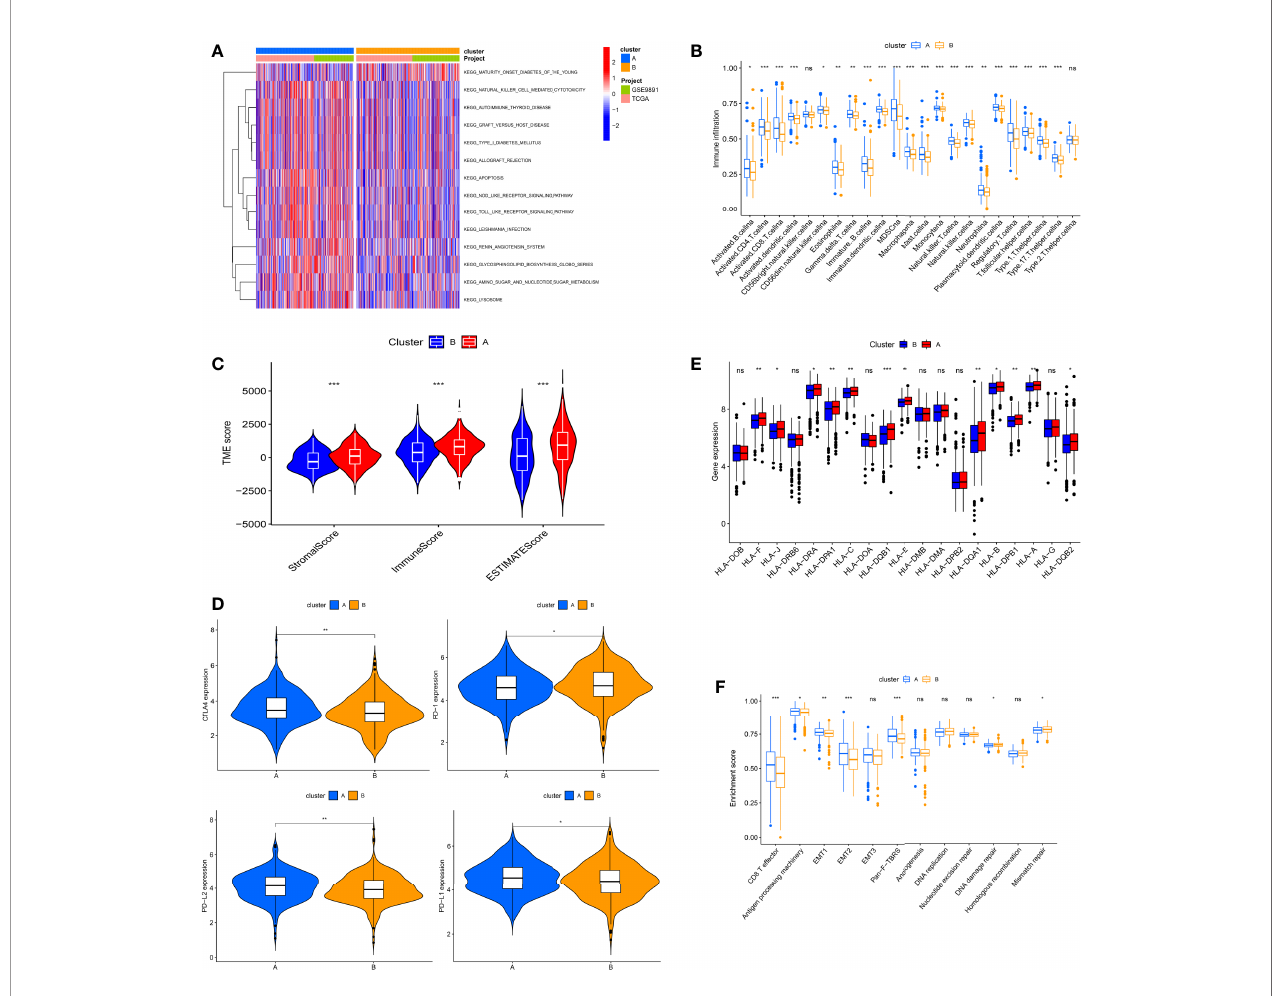
FIGURE 3 | Biological characteristics and tumor immune microenvironment (TME) cell in fi ltration in two RNA modi fi cation patterns of ovarian cancer (OC). (A) Gene Set Variation Analysis (GSVA) analyzed the biological pathways between two modi fi cation patterns. (B) 23 TME cells ’ in fi ltration abundance of two RNA modi fi cation patterns. (C) Correlations between two RNA modi fi cation patterns and TME score. (D) The RNA expression levels of HLA genes in samples from two patterns. (E) Expression levels of CTLA4, PD-1, PD-L2, and PD-L1 in two modi fi cation patterns. (F) Differences in interstitial activation pathways of two RNA modi fi cation patterns. Adjusted p-values were shown as ns, not signi fi cant; * p < 0.05; ** p < 0.01; *** p <